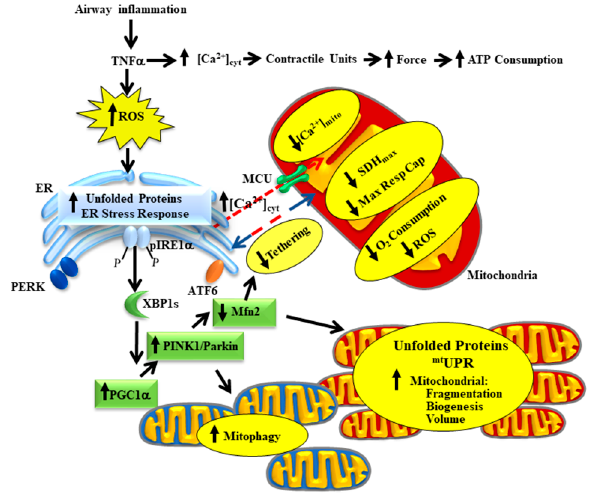
Figure 1. Our conceptual model hypothesizes that, following airway inflammation, TNF α induces an increase in airway smooth muscle (ASM) force generation and ATP consumption leading to increased mitochondrial O 2 consumption and reactive oxygen species (ROS) production. TNF α -induced